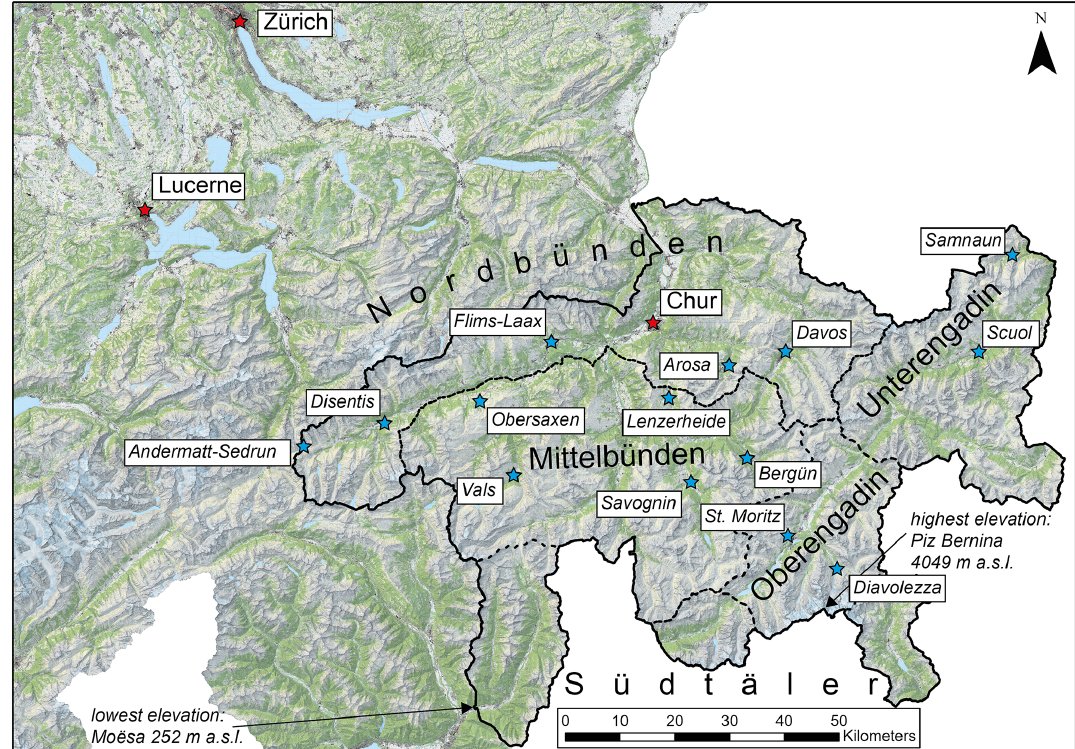
Figure 1. Map of eastern Switzerland visualizing the extent of the canton of Grisons (black outline), the major towns (red stars) and the largest ski resorts (blue stars) as well as the climatic regions (dashed lines) applied in Sect. 3.4 to regionalize the release depth ( d 0) of the avalanches (map source: Swiss Federal Office of